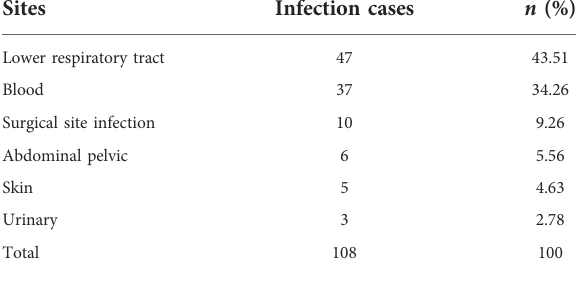
TABLE 3 Distribution of HAI sites in patients in